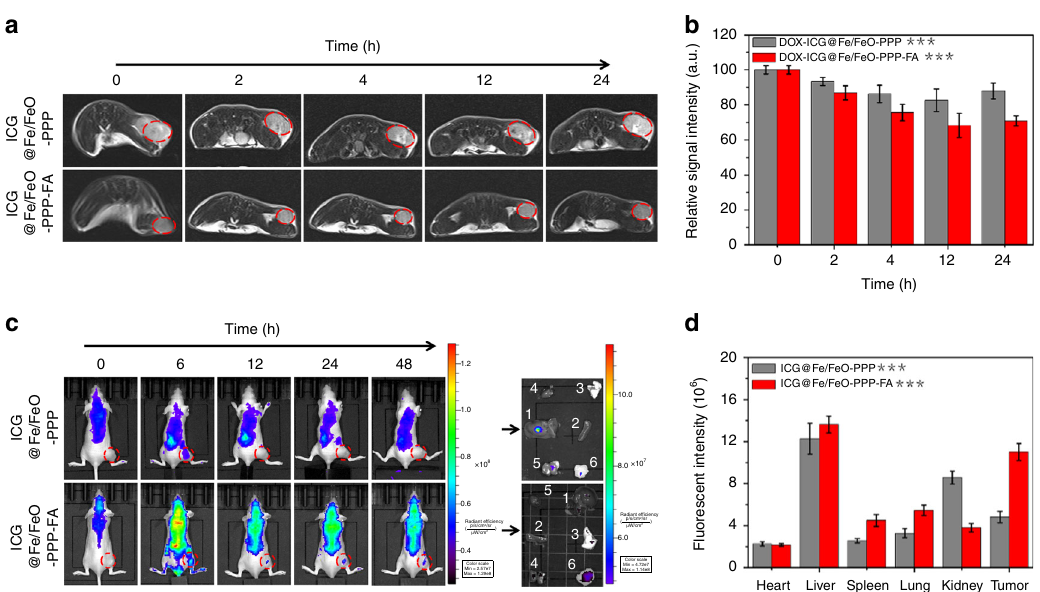
Fig. 5 In vivo imaging. a Real-time MRI of KB tumor-bearing mice after intravenous injection of ICG@Fe/FeO – PPP nanocapsules and ICG@Fe/FeO – PPP – FA nanocapsules. b The relative MRI signal intensities changing at the tumor site after intravenous injection of ICG@Fe/FeO – PPP nanocapsules and ICG@Fe/ FeO – PPP – FA nanocapsules, respectively. c Real-time fl uorescence images of tumor-bearing mice after intravenous injection of ICG@Fe/FeO – PPP nanocapsules and ICG@Fe/FeO – PPP – FA nanocapsules. Ex vivo fl uorescence images of liver (1), spleen (2), lung (3), heart (4), kidney (5) and tumor (6), which were obtained at 48 h post-injection. d The fl uorescence intensities of the major organs after intravenous injection of ICG@Fe/FeO – PPP nanocapsules and ICG@Fe/FeO – PPP – FA nanocapsules, respectively. P values in b and d were calculated by Tukey ’ s post-hoc test (** P < 0.01, *** P < 0.001) by comparing ICG@Fe/FeO – PPP nanocapsules with ICG@Fe/FeO – PPP – FA nanocapsules. Error bars, mean ± SD ( n =